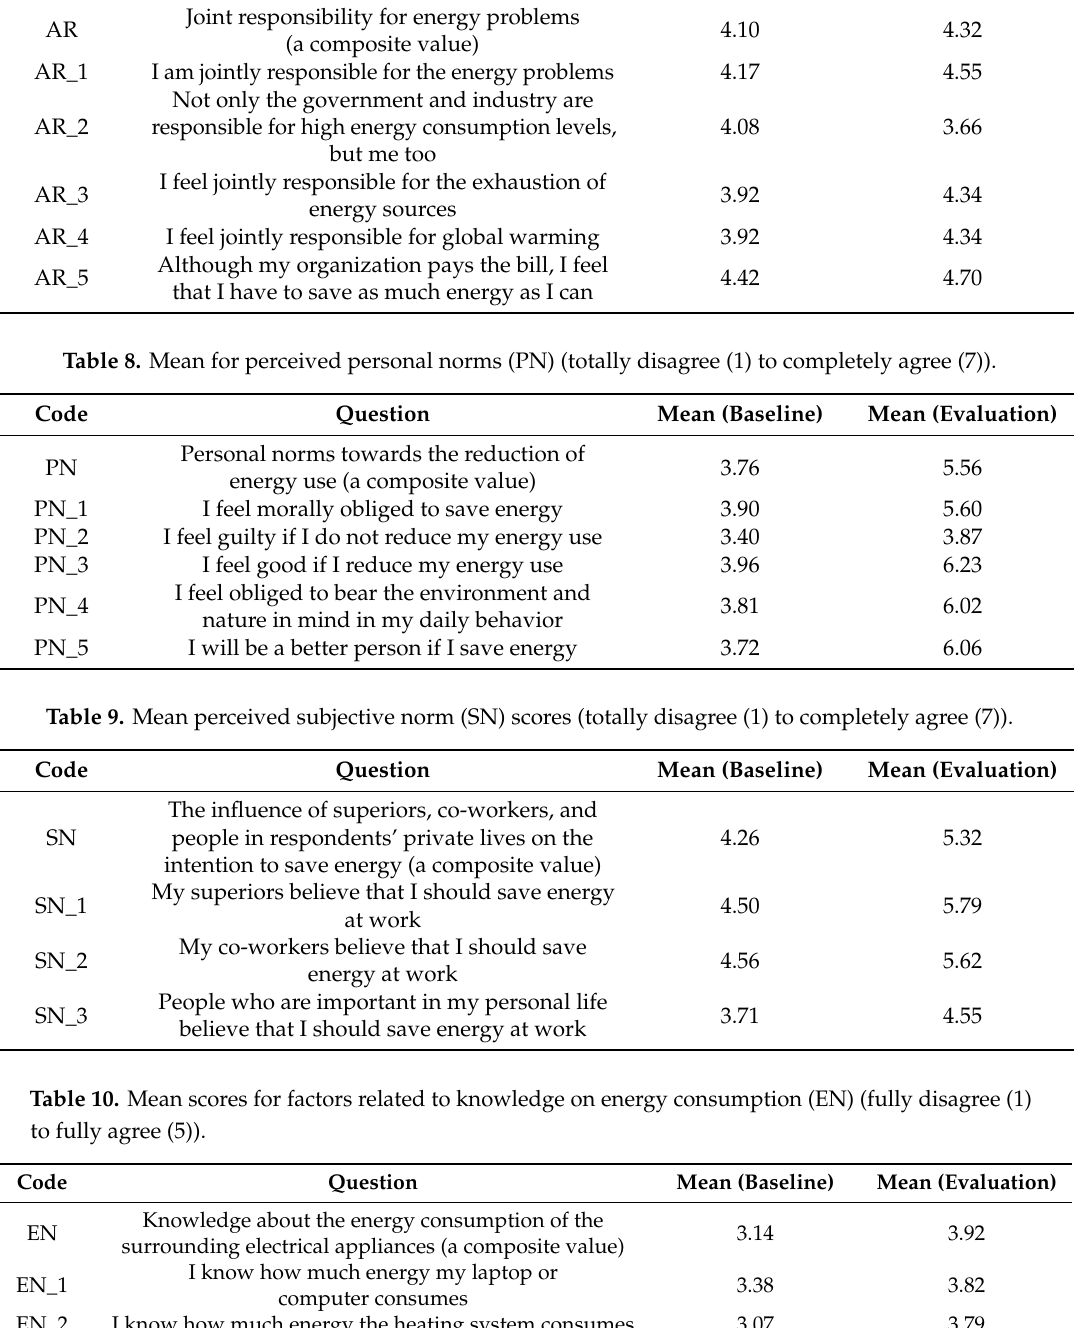
Table 7. Mean score for the ascription of responsibility (AR) factor (fully disagree (1) to fully agree (5)). Code